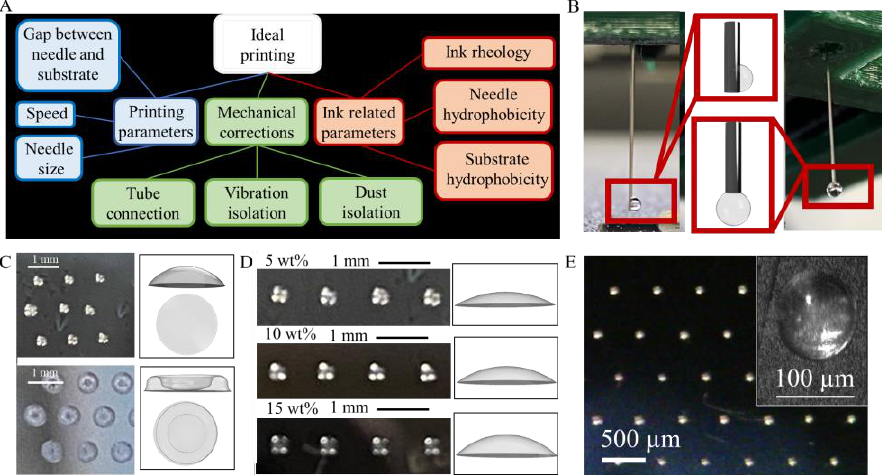
Figure 6. Tunable printing parameters and their influence on dropwise printing quality and the final result. ( A ). Parameters for droplet printing to be monitored. ( B ). drop of hydrophilic ink formation on hydrophilic needle (left) and on hydrophobic needle (right). ( C ). Spherical dome formed on hydrophobized silicon, toroid structure of coffee-ring on pure silicon. ( D ). Spherical dome of different curvature due to different polymer concentration in inks. ( E ). Example of well-tuned microlens printing on a hydrophobic surface with a hydrophobic needle.